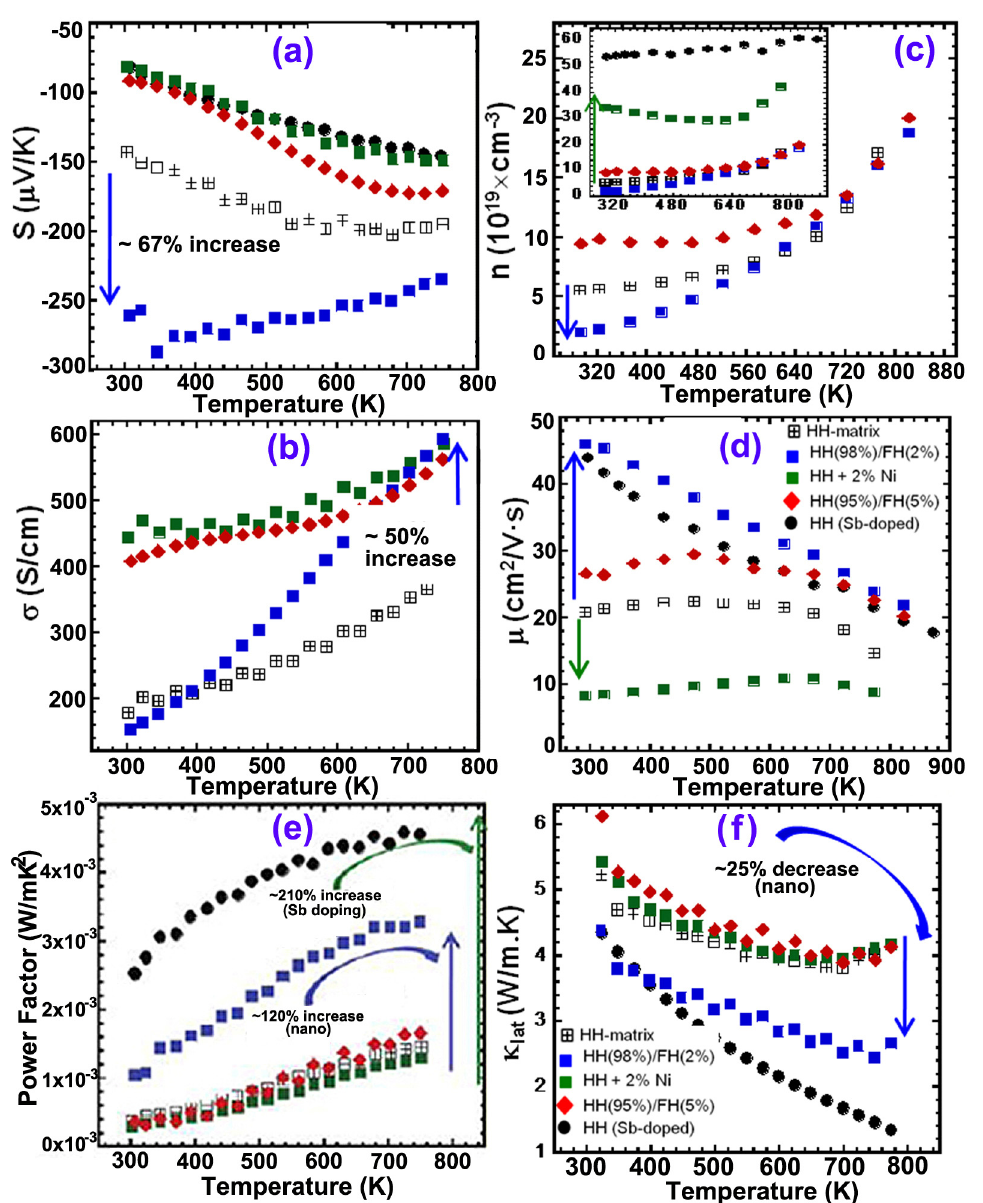
Figure 14. Temperature dependence of the thermal and electrical properties of HH(1 − x )-FH( x ) bulk nanocomposites ( x = 0.02, 0.05) compared to that of Zr matrix and Sb-doped and nanostructure-free Zr alloy: ( a ) Seebeck coefficient; ( b ) electrical conductivity; ( c ) carrier concentration; ( d ) carrier mobility; ( e ) power factor; ( f ) lattice thermal conductivity. Reproduced with permission from Reference [80]. Copyright 2011, American Chemical